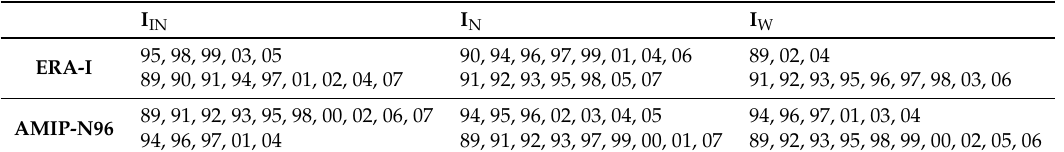
Table 1. Years used to create moisture flux composites. Columns indicate the WPSH indices the composites are associated with. For each data set (ERA-I and AMIP-N96), there are two rows. The top (bottom) row shows years of positive (negative) index anomalies and corresponds to the + ( − ) sign used in the